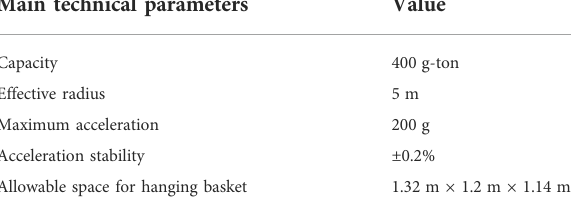
TABLE 2 The main technical parameters of NHRI-400 g-ton geotechnical